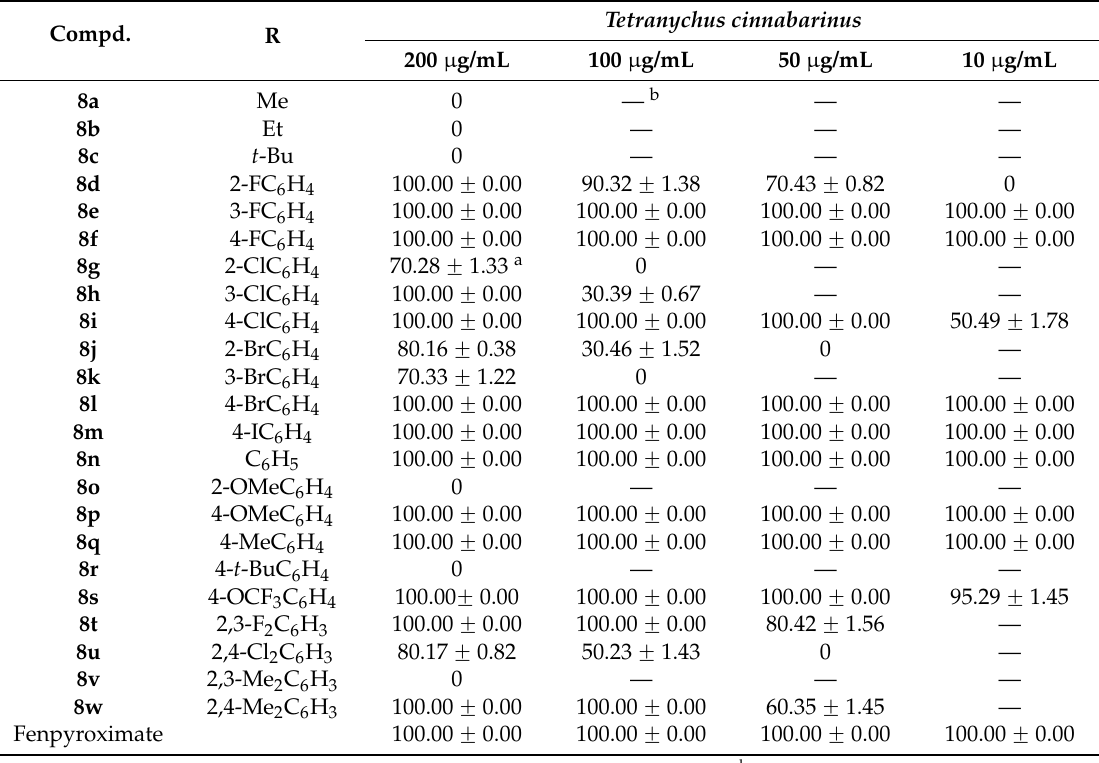
Table 1. Acaricidal activities of compounds 8a – 8w (mortality,